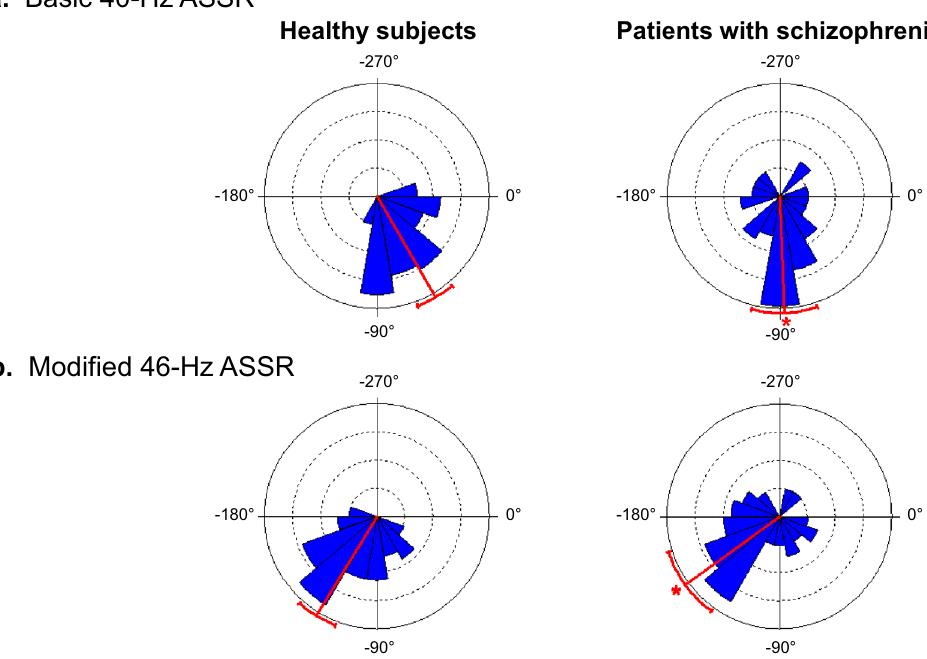
Figure 1. Comparison of phases between patients with schizophrenia and case-matched healthy subjects in the basic 40-Hz ASSR ( a ) and the modified 46-Hz ASSR ( b ). The rose diagrams depict the distributions of the phase of ASSR in healthy subjects (left panels) and patients with schizophrenia (right panels). Each area of wedges in the diagrams represents the number of subjects who fall into each bin of the phases. The phases were significantly delayed in patients with schizophrenia compared with healthy subjects in both ASSRs. The red bar line and arc represent the mean of the phases of ASSR and the 95% confidence limit, respectively. * p <